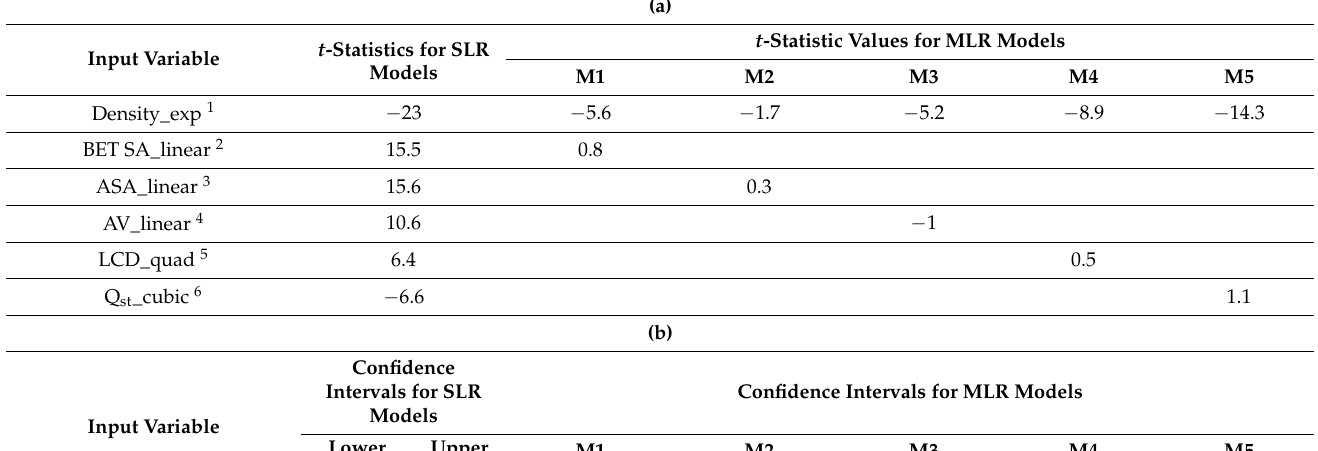
Table 7. ( a ) Comparison of the t -statistic values of the coefficient regression estimates for the two- input MLR models, with density as one of the inputs and the individual SLR models. The details of the MLR models are given in the footnote below the table. ( b ) Comparison of the confidence intervals of the coefficient regression estimates for the two-input MLR models, with density as one of the inputs and the individual SLR models. The details of the MLR models are given in the footnote below the table. ( c ) Comparison of the partial correlations of the coefficient regression estimates for the two-input MLR models, with density as one of the inputs and the individual SLR models. The details of the MLR models are given in the footnote below the table. ( d ) Comparison of the F -statistic values for the 2-input MLR models with density as one of the inputs and the individual SLR models. The details of the MLR models are given in the footnote below the